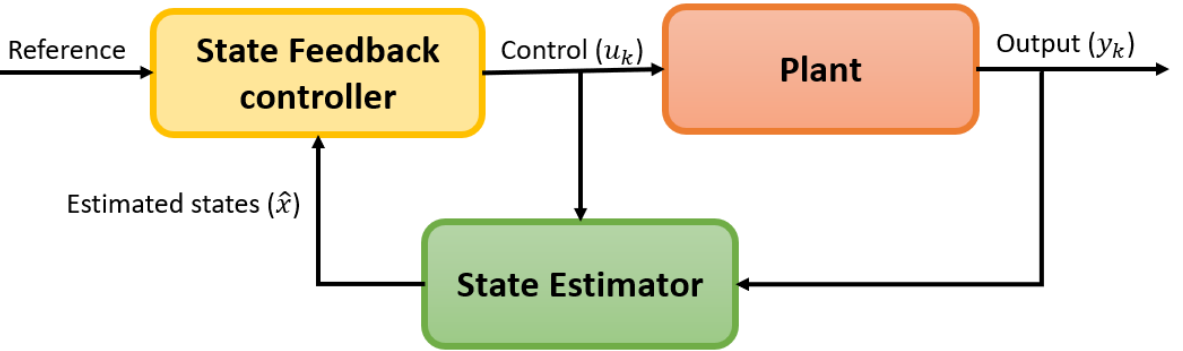
Figure 1. Classic control strategy based on state estimation